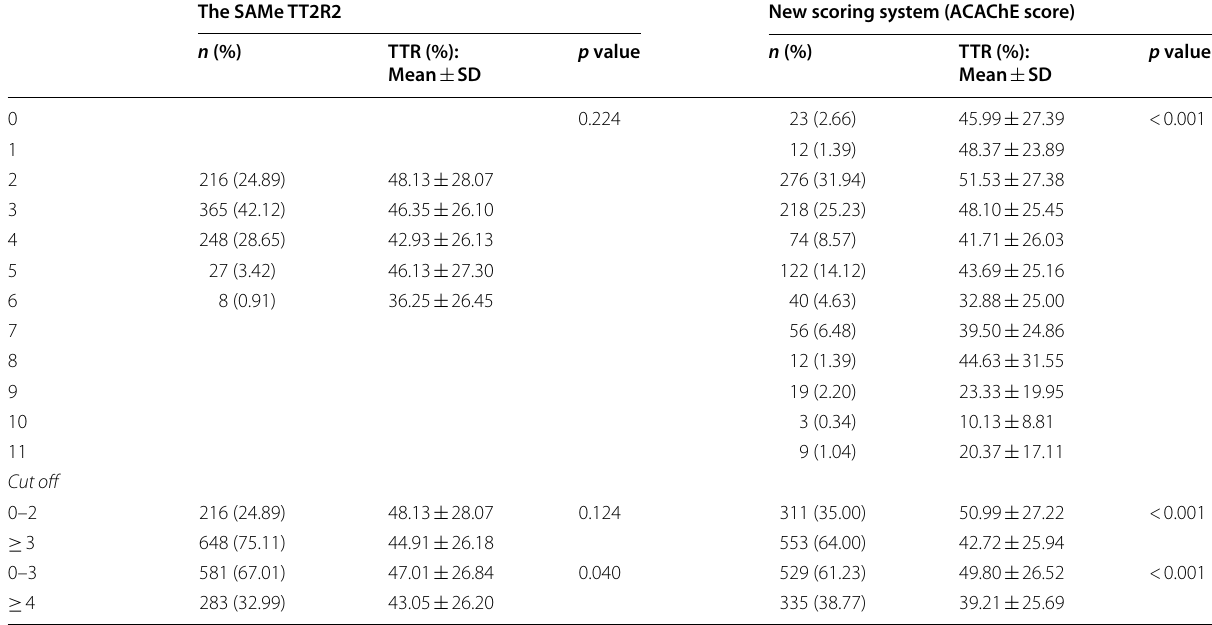
Table 5 TTR in relation to the SAMe TT2R2 and new scoring system (ACAChE score) The SAMe